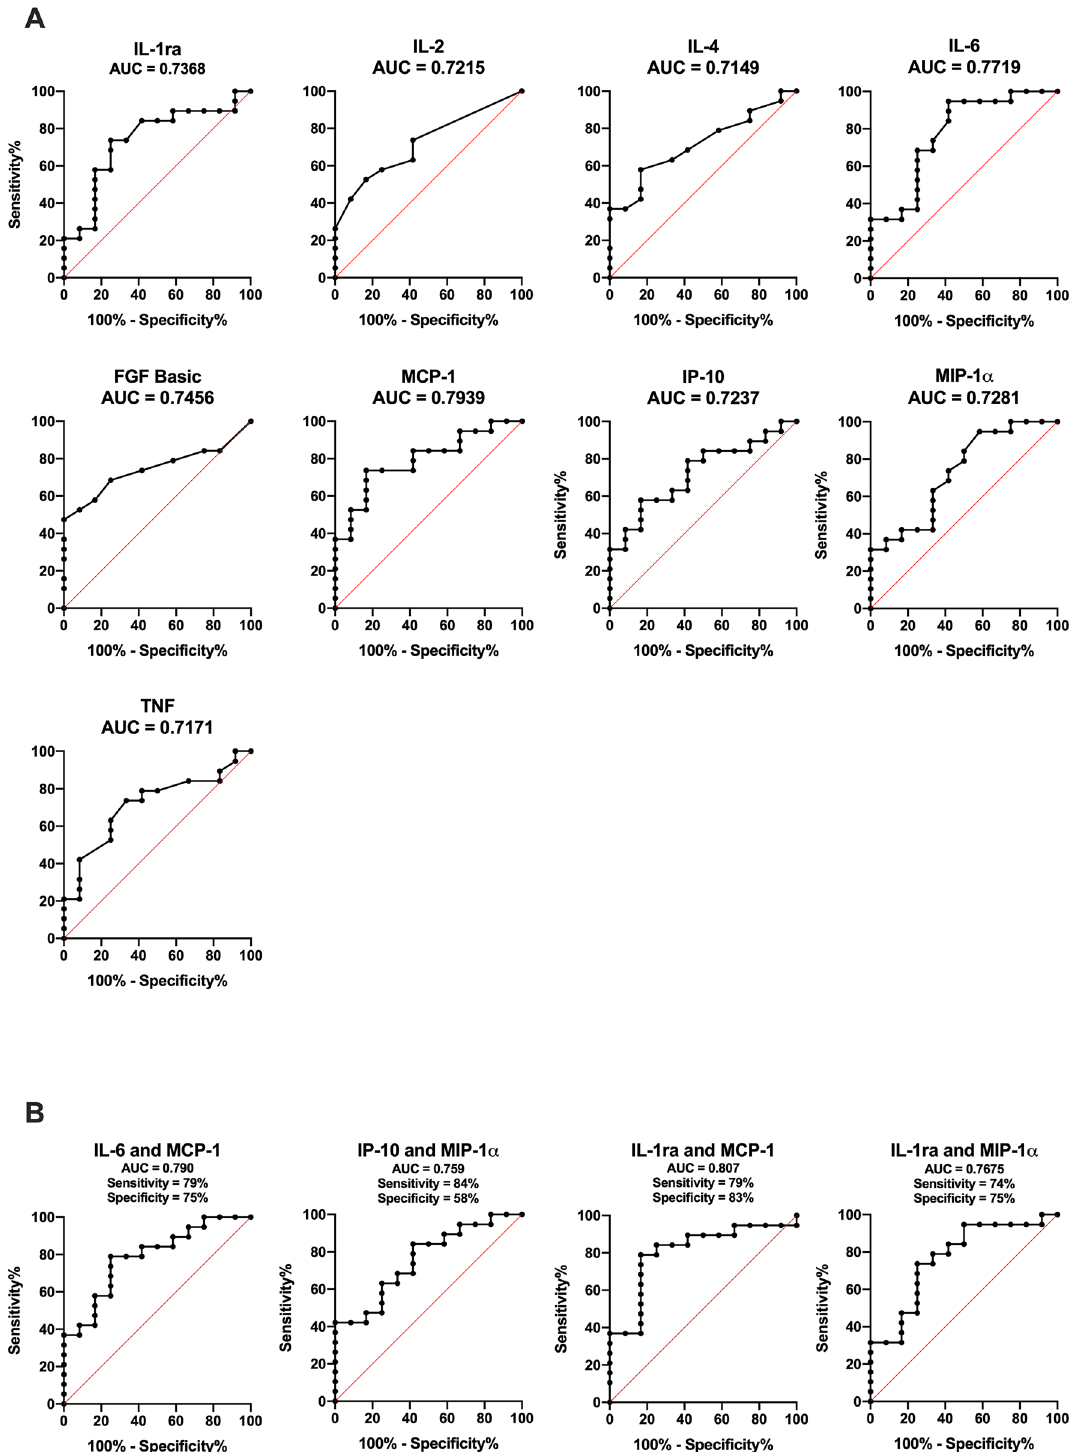
Figure 2. ROC analyses of cytokines in patients with respiratory failure. The receiver operating characteristic (ROC) curve was calculated comparing baseline plasma ( A ) cytokine levels and ( B ) combination of cytokine levels in RF vs non-RF patients with calculated sensitivity and specificity. Area under the ROC curve (AUROC) p values were < 0.05. Cytokines for ROC analyzes were selected on whether they showed significant difference between the two groups (Fig.